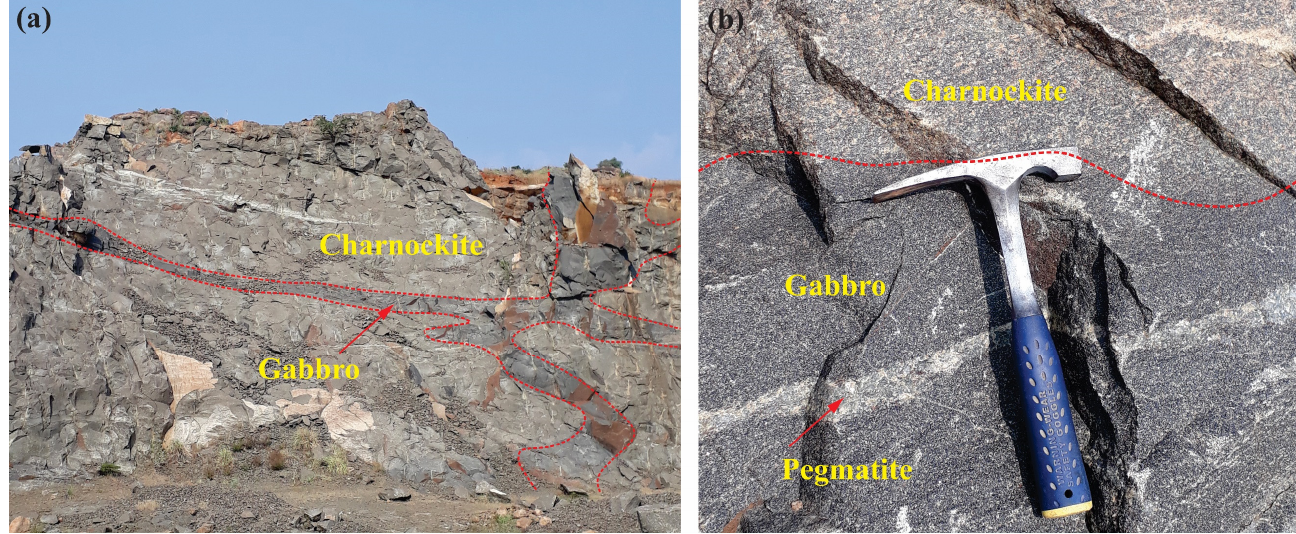
Figure 3. Field photographs of gabbros from Nagercoil block. ( a ) Gabbro band within massive charnockite; ( b ) Contact between gabbro and charnockite.